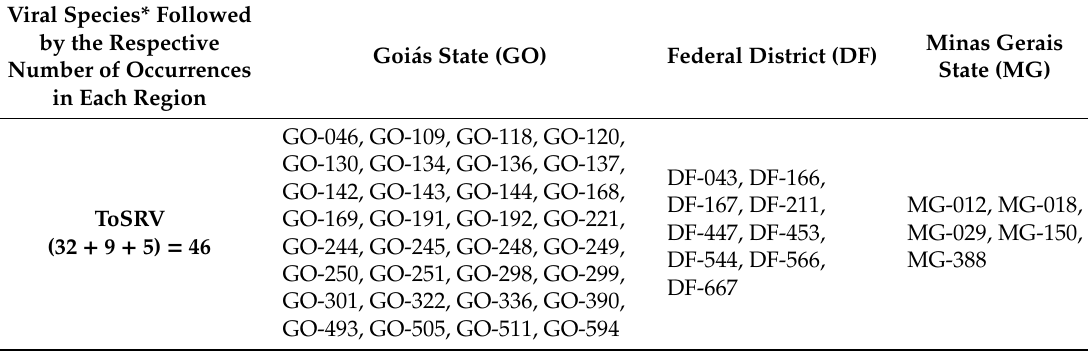
Table 6. Relative frequency of Begomovirus and other circular single-stranded DNA viruses detected after Illumina Hiseq sequencing of 63 tomato DNA samples lacking the Ty -1